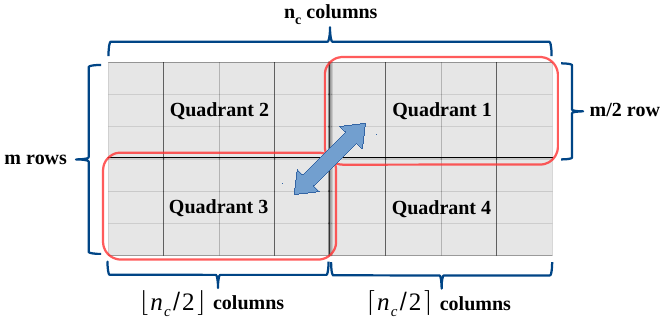
Figure 4. Swapping of the WDT quadrants in case of reduced systems and m ∈ G .